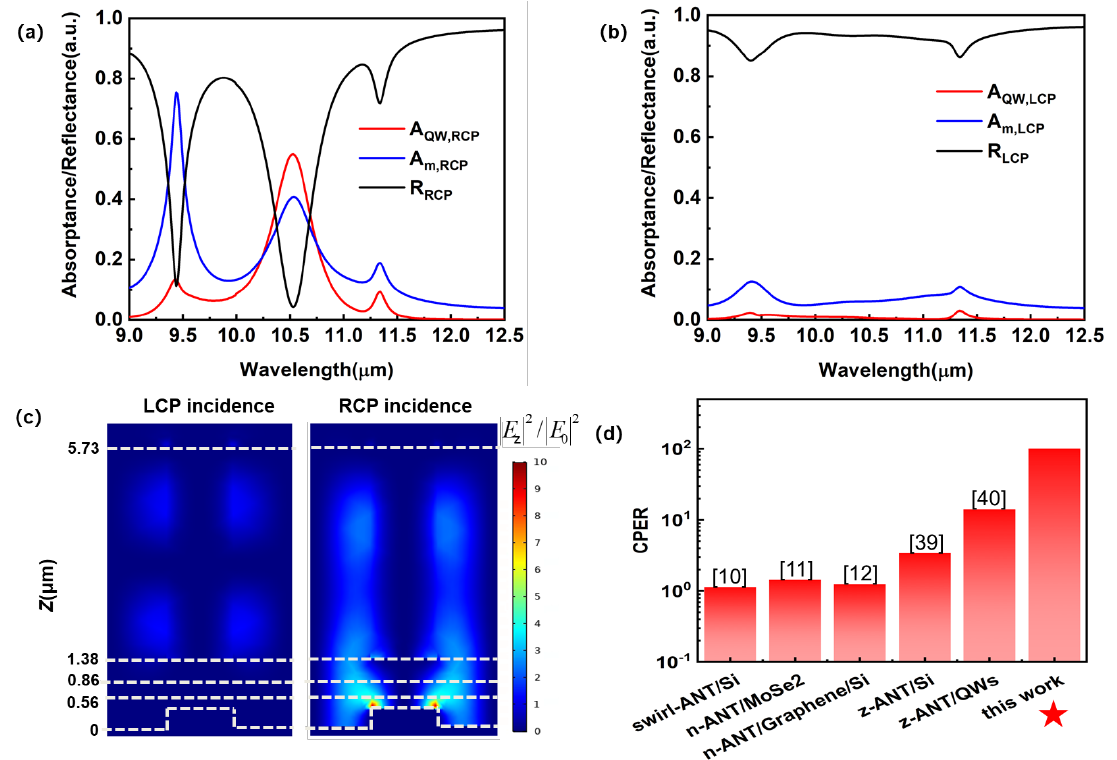
Figure 2. ( a ) Absorptance and reflectance spectra of the dielectric-metal-hybrid chiral metamirror integrated QWIP under RCP illumination. A QW, RCP denotes the absorptance of the QWs, A m, RCP denotes the absorptance of the metal, R RCP denotes the reflectance of RCP. ( b ) Absorptance and re-flectance spectra of the dielectric-metal-hybrid chiral metamirror integrated QWIP under LCP illu-mination. A QW, LCP denotes the absorptance of the QWs, A m, LCP denotes the absorptance of the metal, R LCP denotes the reflectance of LCP. ( c ) Field distributions on the x - z cross section of the dielectric-metal-hybrid chiral metamirror integrated QWIP under LCP and RCP illumination, respectively. The wavelength of the incident light is 10.55 µ m. The colored surfaces represent | E z | 2 /| E 0 | 2 . ( d ) Comparison of between the CPER of our device and the reported CPERs of different integrated circularly polarized